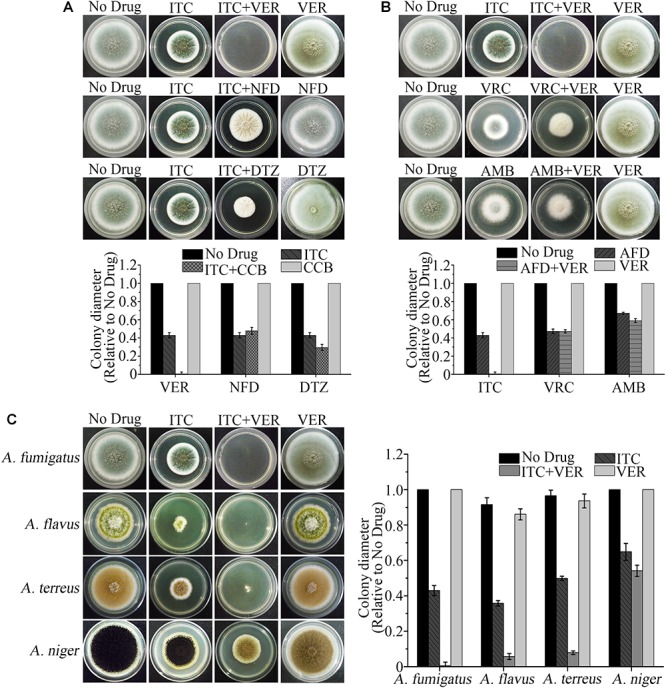
The ITC-VER combination is the most promising candidate among antifungal drugs and calcium channel blockers (CCBs) against Aspergillus spp. (A) Testing the growth inhibition on agar plates by itraconazole (ITC) (0.1 μg/ml) with different CCBs, including verapamil (VER), nifedipine (NFD) and diltiazem (DTZ), at 200 μg/ml against an A. fumigatus stain. (B) Testing the growth inhibition on agar plates by VER (600 μg/ml) with different antifungal drugs (AFD), including ITC (0.1 μg/ml), voriconazole (VRC) (0.05 μg/ml) and amphotericin B (AMB) (1.5 μg/ml), against an A. fumigatus stain. (C) Testing the growth inhibition on agar plates by the ITC-VER combination against A. fumigatus (0.1 and 200 μg/ml, respectively), A. flavus (0.04 and 50 μg/ml, respectively), A. terreus (0.1 and 50 μg/ml, respectively) and A. niger (0.1 and 600 μg/ml, respectively).